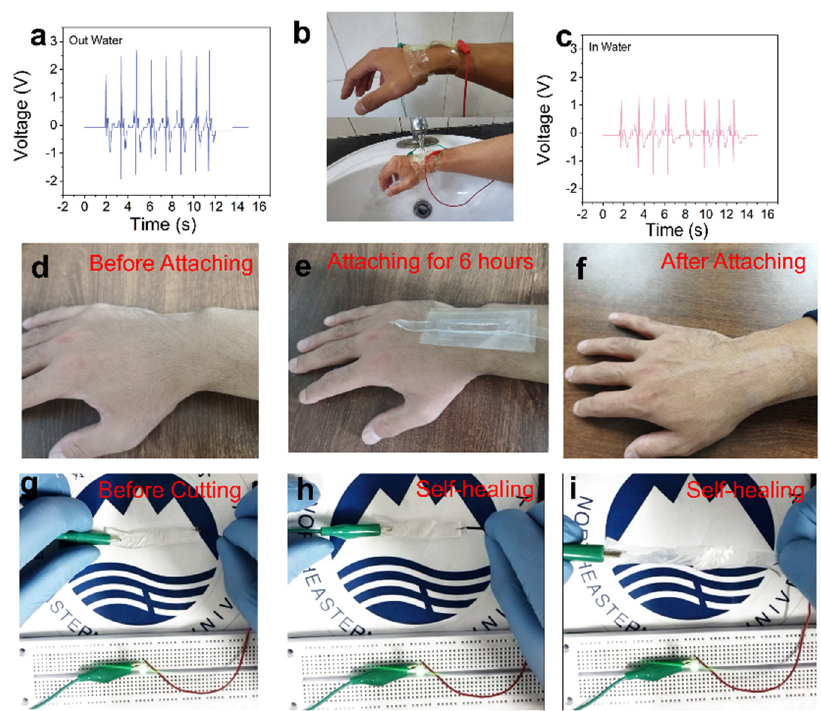
Figure 6. Scenes of waterproof, biocompatibility, and self-healing. ( a – c ) Test of waterproof